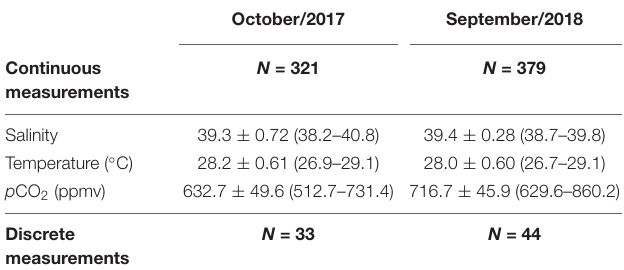
TABLE 1 | Main physico-chemical parameters analyzed in this study (average, standard deviation, minimum, and maximum